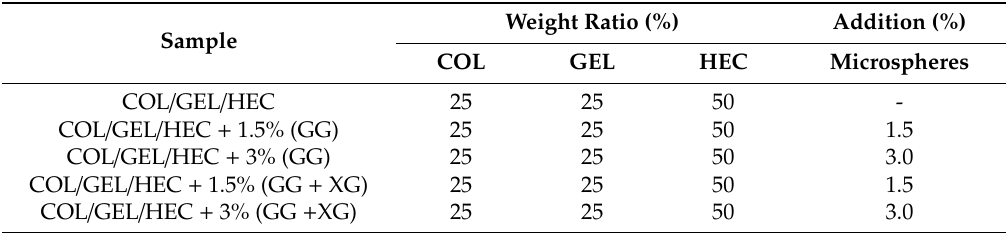
Table 1. The types of prepared matrices composed of collagen (COL), gelatin (GEL), and hydroxyethyl cellulose (HEC) containing di ff erent amount of